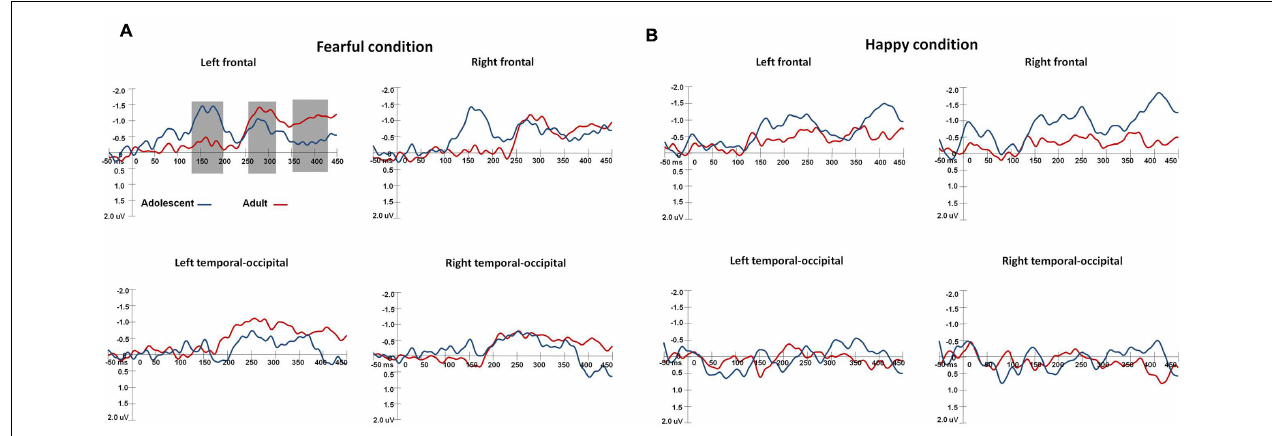
FIGURE 3 | The waveforms of vMMNs in both happy and fearful conditions. The ERP responses in the electrodes of F1, FC1, and C1 were averaged to plot the neural activity over the left frontal areas, and F2, FC3, and C2 were averaged for the right frontal areas. The ERP responses in the electrodes of TP7, P7, PO7, CB1, and O1 were averaged to plot the neural activity over the left occipito-temporal areas, and TP8, P8, PO8, CB2, and O2 averaged for the right occipito-temporal areas. (A) Shows the vMMN waveforms in the fearful condition, and (B) for the vMMN waveforms in the happy condition.